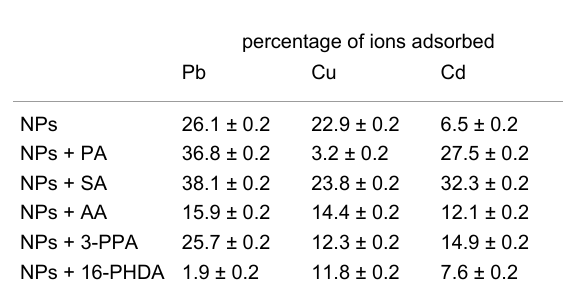
Table 4: Percentage of ions adsorbed by Mn 0.5 Fe 2.5 O 4 nanoparticles modified with different linkers measured by AAS. As a reference, unmodified nanoparticles were